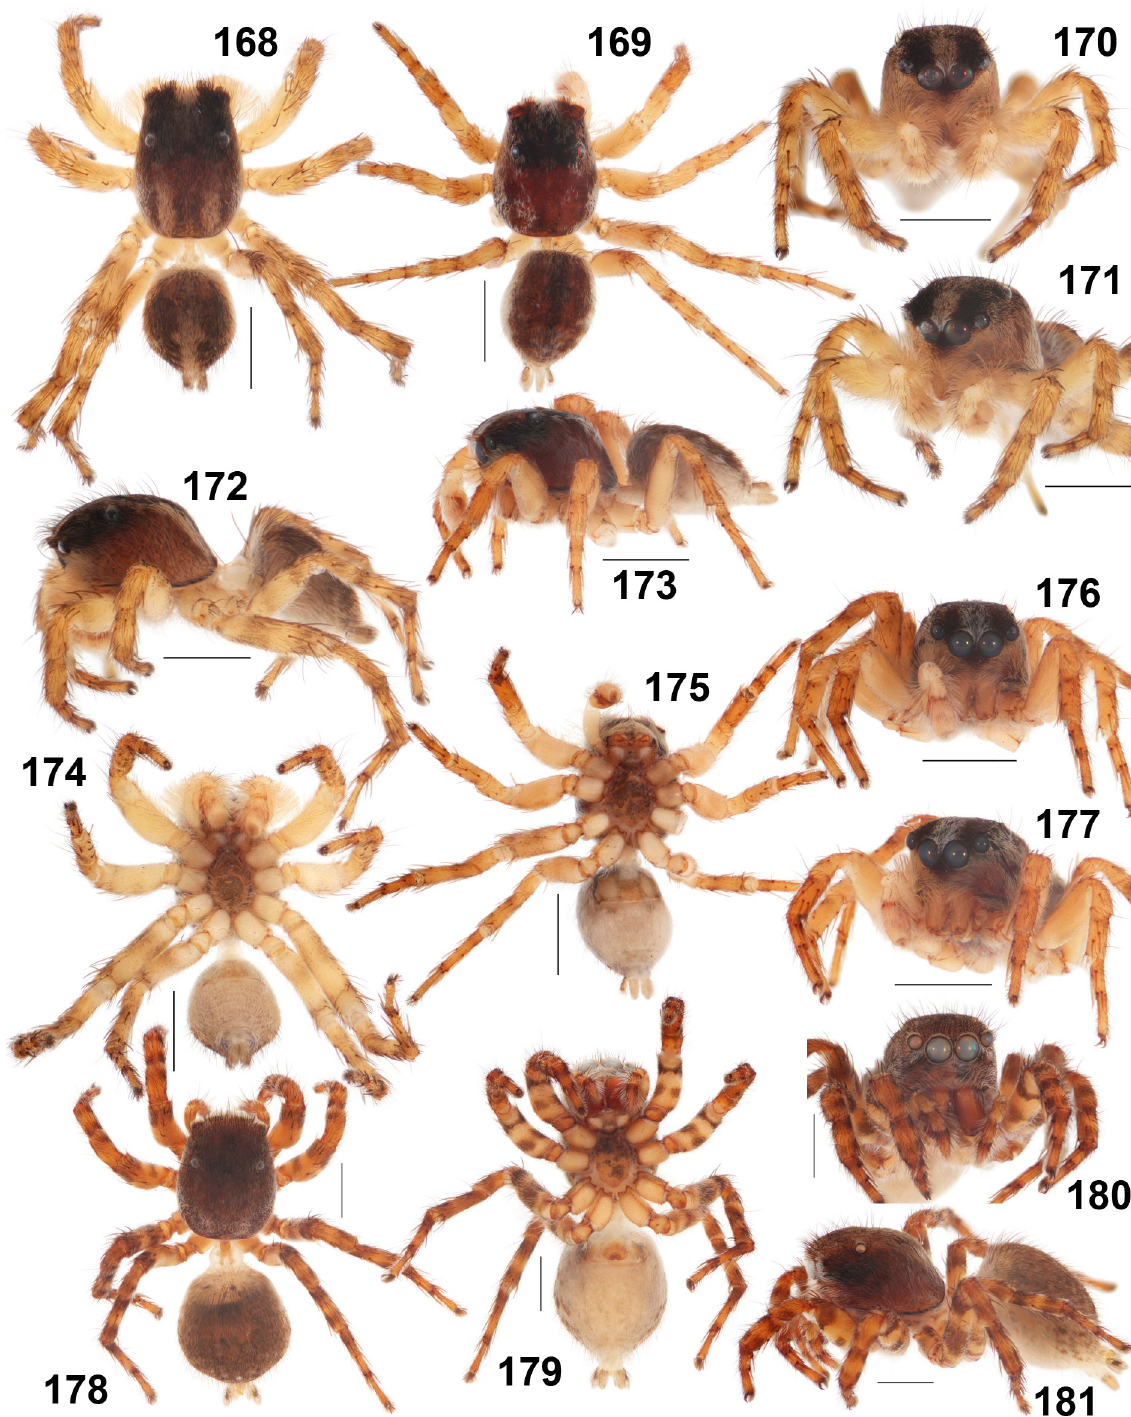
Figs 168–181. Manzuma petroae gen. et sp. nov., paratypes, ♂♂ from Roodeport (168, 170–172, 174, ISEA 001.7212) and Tuinplaas (169, 173, 175–177, NCA 2016/382), paratype, ♀ from Ithala GR (178– 181, NCA 2019/712), general appearance. Scale bars: 1